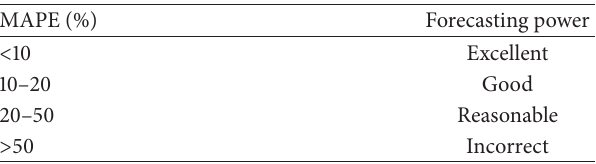
Table 1: Criterion of